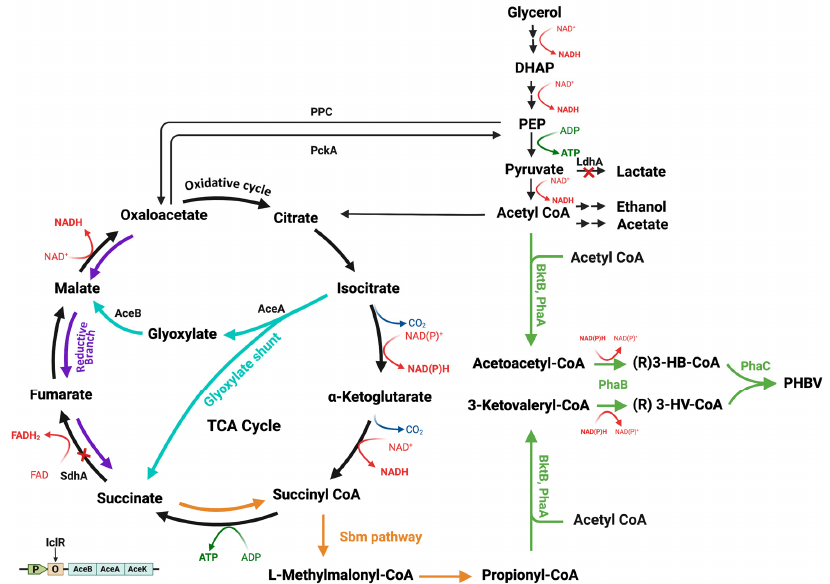
Figure 2. Schematic representation of engineered PHBV pathway in E. coli using glycerol as the carbon source. TCA cycle is presented in black. The reductive branch of the TCA cycle is show with purple arrows. Blue arrows represent the glyoxylate shunt in TCA cycle. The activated Sleeping beauty mutase (Sbm) pathway is presented in orange arrows. PHBV pathway and heterologous enzymes from C. necator are shown in green. Metabolite abbreviations: PHBV, Poly(3-hydroxy- butyrate-co-3-hydroxyvalerate); (R)-3-HB-CoA, (R)-3-hydroxybutyryl-CoA; (R)-3-HV-CoA, (R)-3- hydroxyvaleryl-CoA; DHAP, dihydroxyacetone phosphate; PEP, phosphoenolpyruvate. Protein ab- breviations: AceA, isocitrate lyase; AceB, malate synthase A; AceK, isocitrate dehydrogenase ki- nase/phosphatase; IclR, AceBAK operon repressor; LdhA, lactate dehydrogenase A; PckA, phos- phoenolpyruvate carboxykinase; PPC, phosphoenolpyruvate carboxylase; PhaA, acetoacetyl-CoA thiolase; PhaB, acetoacetyl-CoA reductase; PhaC, PHA synthase; Sbm, methylmalonyl-CoA mutase; SdhA, succinate dehydrogenase subunit.